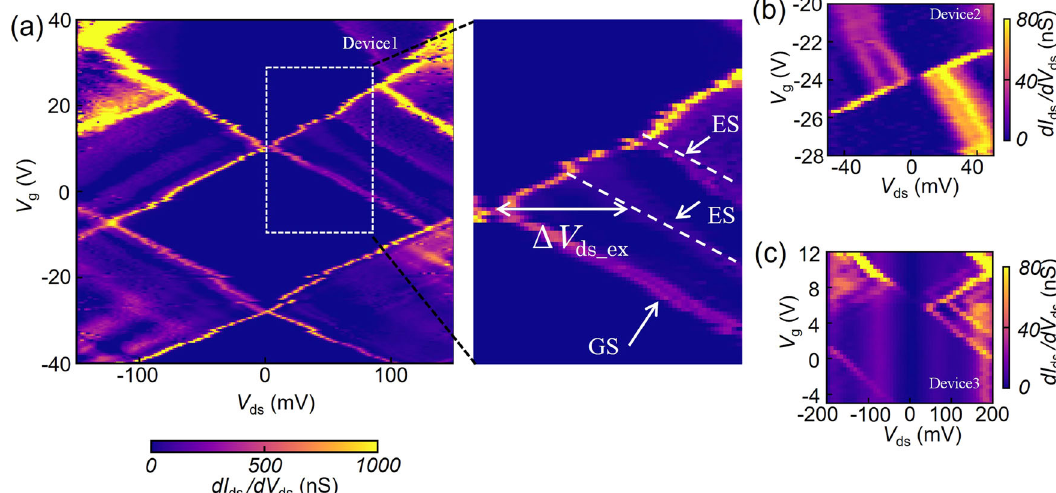
Fig. 4 GS and ES of CDs in our GNR device. a – c Typical Coulomb diamonds with GS and ES lines measured at 2.2 K for various GNR devices ( a Device 1, b Device 2, and c Device